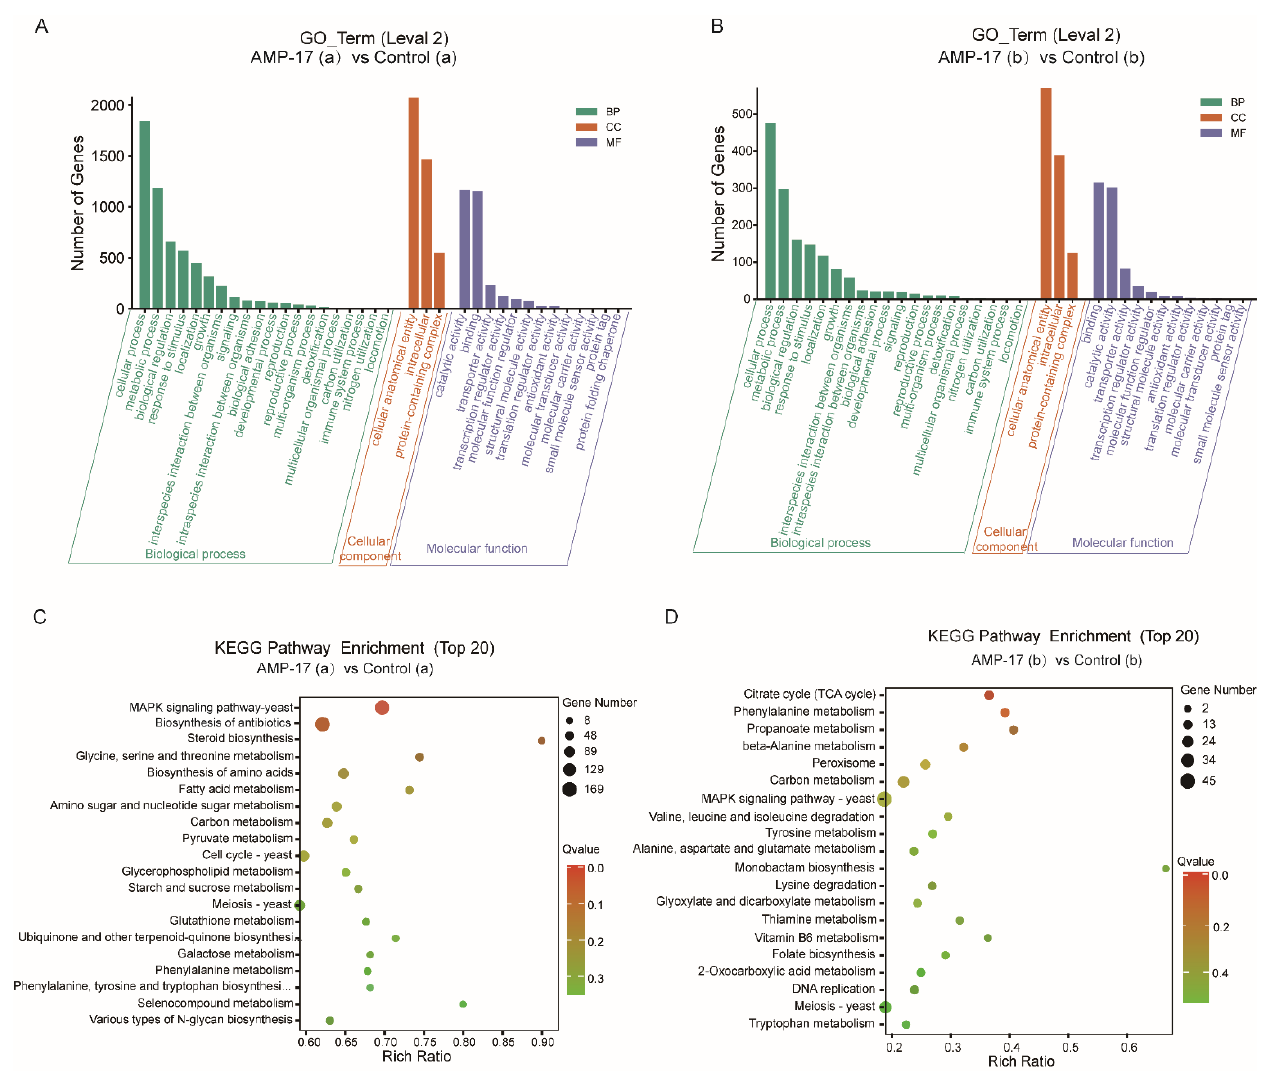
Figure 7. The functional annotation and classification of DEGs. ( A , B ) The GO classification of DEGs in the biofilm formation of C. albicans after 32 μg/mL AMP -17 for 12 h ( A ) or preformed biofilm of C. albicans after 128 μg/mL AMP -17 for 12 h ( B ). ( C , D ) The scatter plot of KEGG enrichment of DEGs in the biofilm formation of C. albicans after 32 μg/mL AMP -17 ( C ) or preformed biofilm of C. albicans after 128 μg/mL AMP -17 ( D ). “a” in the above figure indicate s early forming biofilm (12 h), while “b” indicate s preformed biofilm.